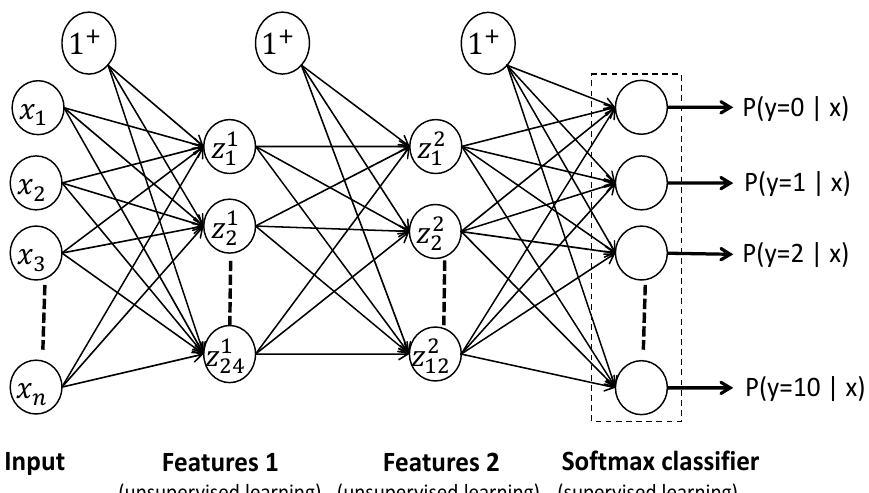
Figure 3. Block diagram of stacked sparse autoencoders (SSAE) used in this work. Features at layer 1 were improved by minimizing the error using Equation (3). These improved features were then fed as input to the next AE and again, improved features at layer 2 were fed to the softmax classifier where labels were obtained. All layers were trained independently from each other and were stacked